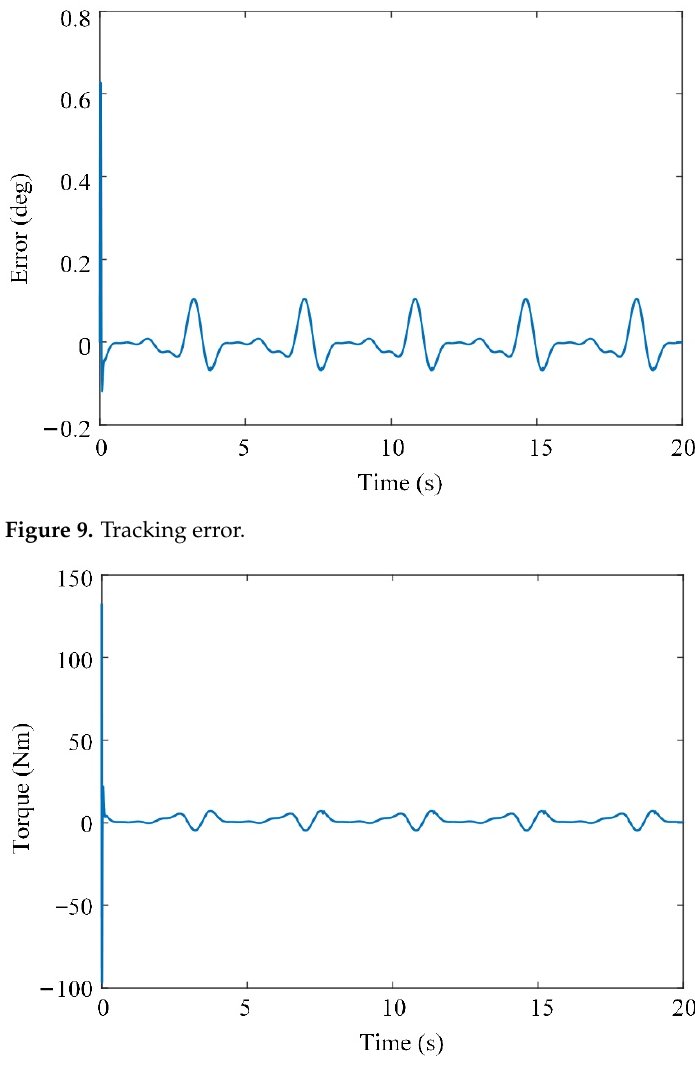
Figure 11. The prototype and control system.